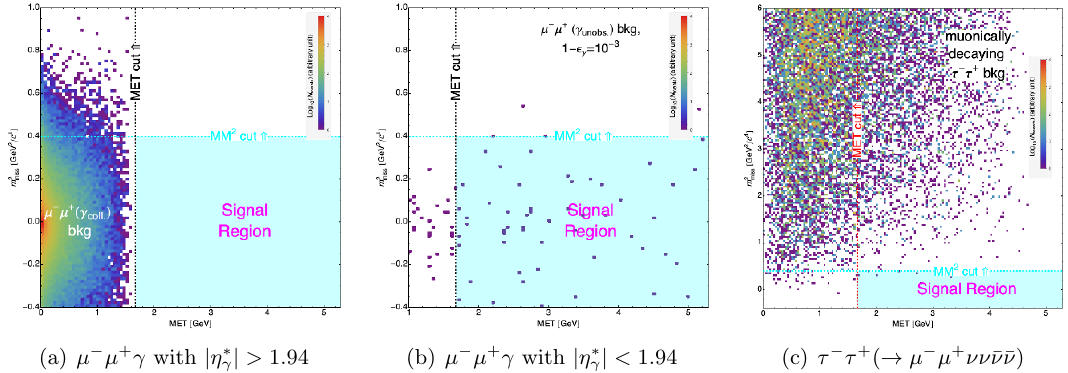
Figure 8 . Distributions of SM background events (cid:22) (cid:0) (cid:22) + ( (cid:13) ), (cid:28) (cid:0) (cid:28) + ( ( =E , m 2 ) space. In the case of (cid:22) (cid:0) (cid:22) + + (unobserved) (cid:13) background with T miss the case of photon detection ine(cid:14)ciency 1